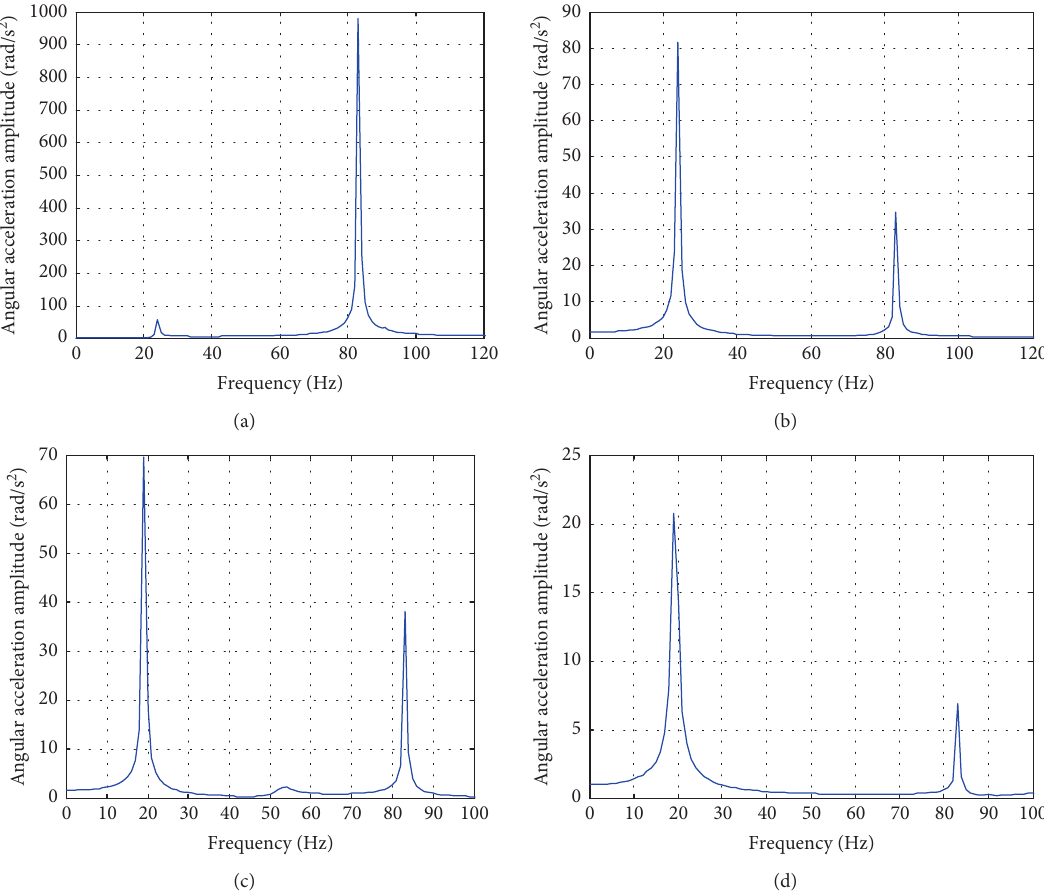
Figure 16: Spectra of J 8 and J 10 at 2500r/min of engine speed: (a) spectrum of J 8 and (b) spectrum of J 10 of DMF; (c) spectrum of J 10 of DMF with simple CPVA; (d) spectrum of J 10 of DMF with bifilar